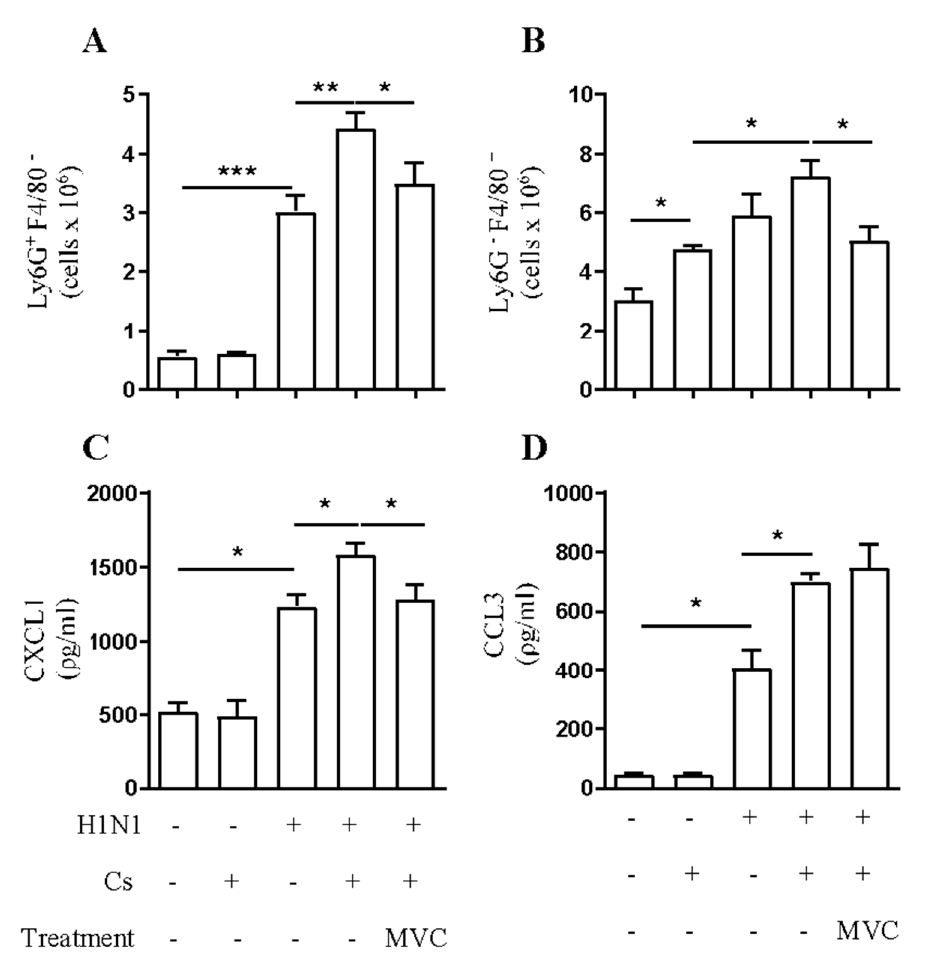
Figure 3. Maraviroc reduces increased macrophage and neutrophil infiltration in the lung tissue of CsH1N1 mice. Effect of Maraviroc on the numbers of ( A ) CD45 + /F4/80 − /Ly6G + (Neutrophils), ( B ) CD45 + /F4/80 + /Ly6G − cells (Macrophages), and the levels of CXCL1 ( C ) and CCL3 ( D ) in the lung tissue of mice exposed to Cs and infected with influenza A virus (CsH1N1). Data are expressed as mean ± SEM from at least 6 mice. * p < 0.05, ** p < 0.01, *** p < 0.001. Differences were statistically evaluated One-Way ANOVA with Tukey post-test.